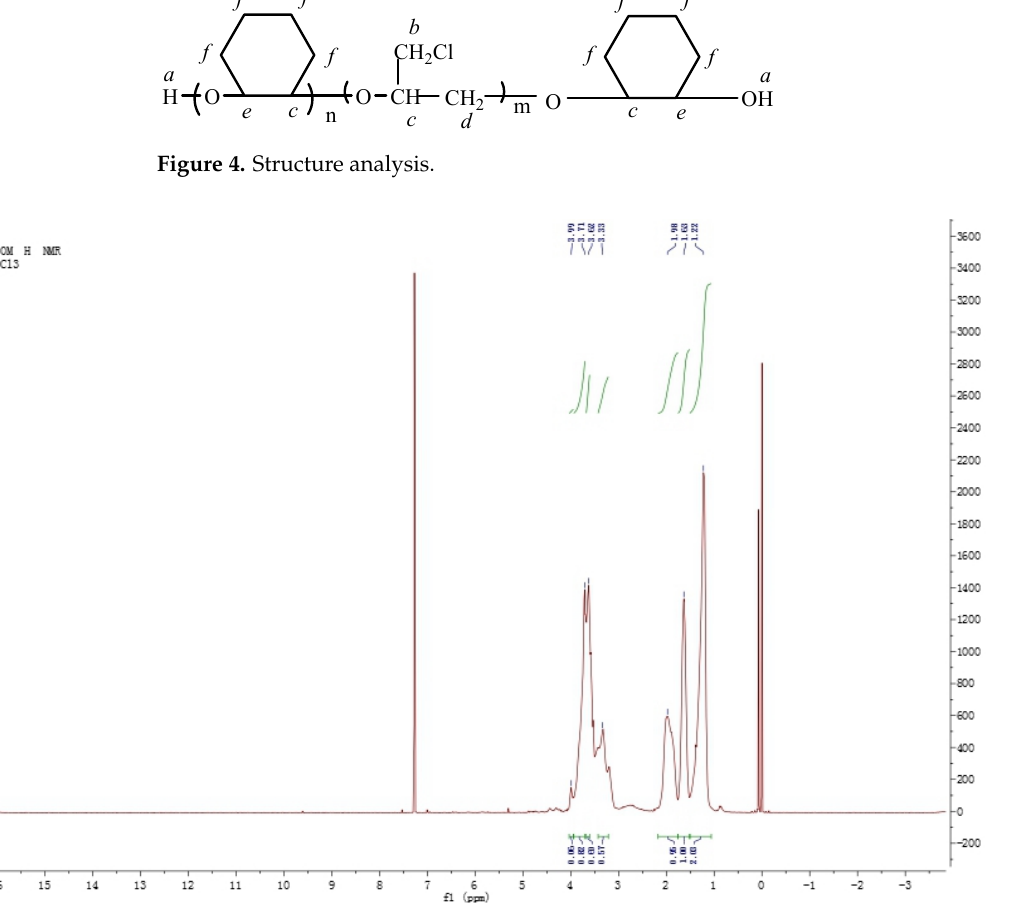
Figure 5. 1 HNMR of the synthetic copolyether (dissolving in CDCl 3 , tetramethylsilane as an internal standard, 400 MHz of resonance frequency).